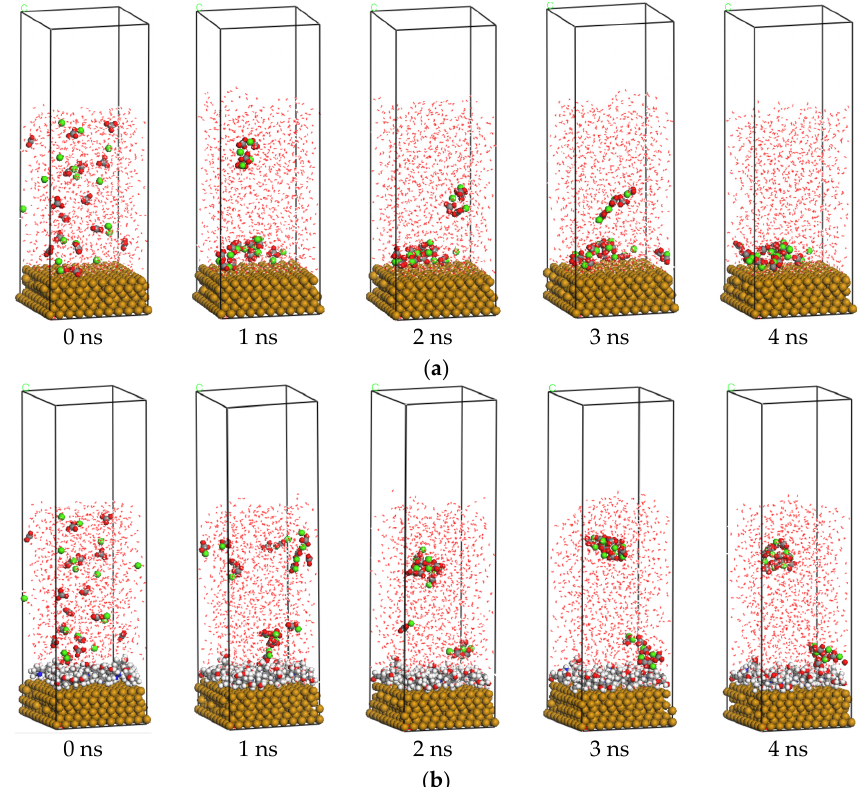
Figure 8. Adsorption configurations of CaCO 3 on ( a ) Fe plate and ( b ) PDA coating.